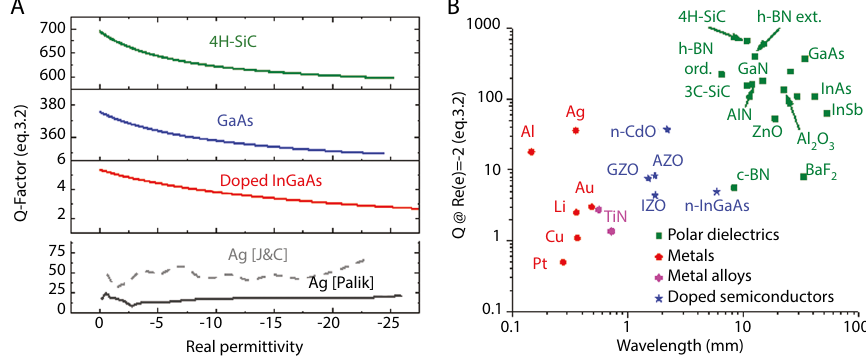
Ga As (red trace) 0.3 0.7